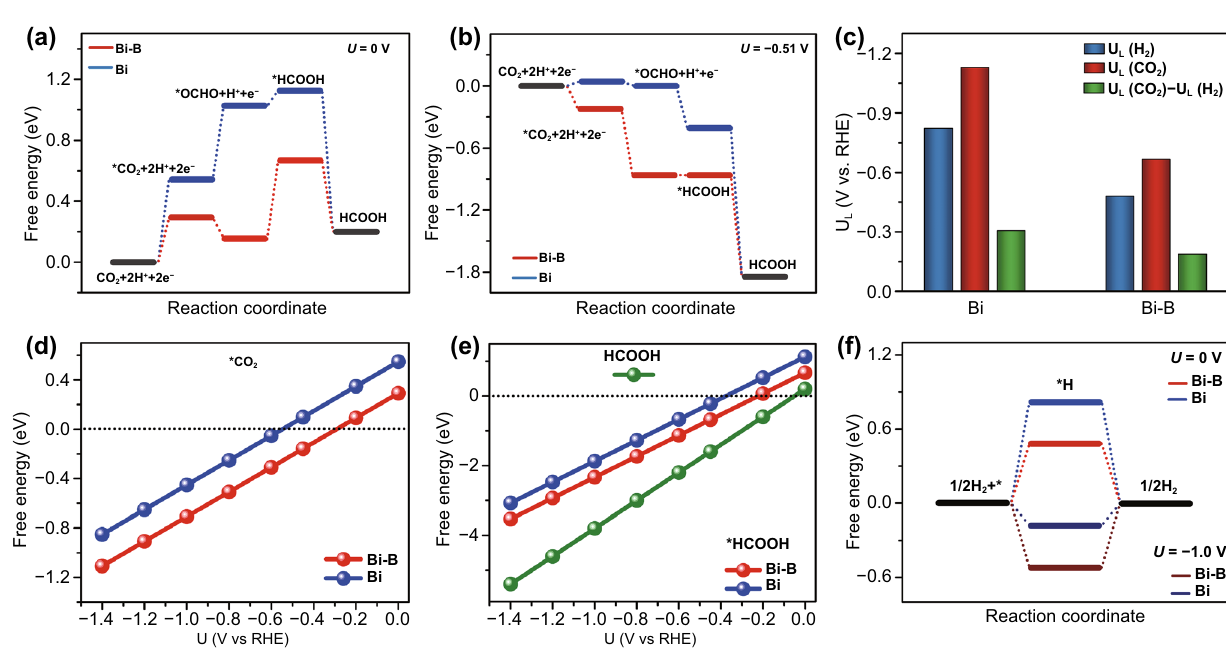
Fig. 4 Mechanistic free‑energy diagrams at external potential U (versus reversible hydrogen electrode (RHE) at pH 0, 298 K, and 1 atm) of a 0 V and b ‑0.51 V, c difference in limiting potentials for CO 2 reduction and H 2 evolution, free energies of d *CO 2 , e *HCOOH and f *H at differ‑ ent U on pristine Bi (012) and Bi‑B (012)